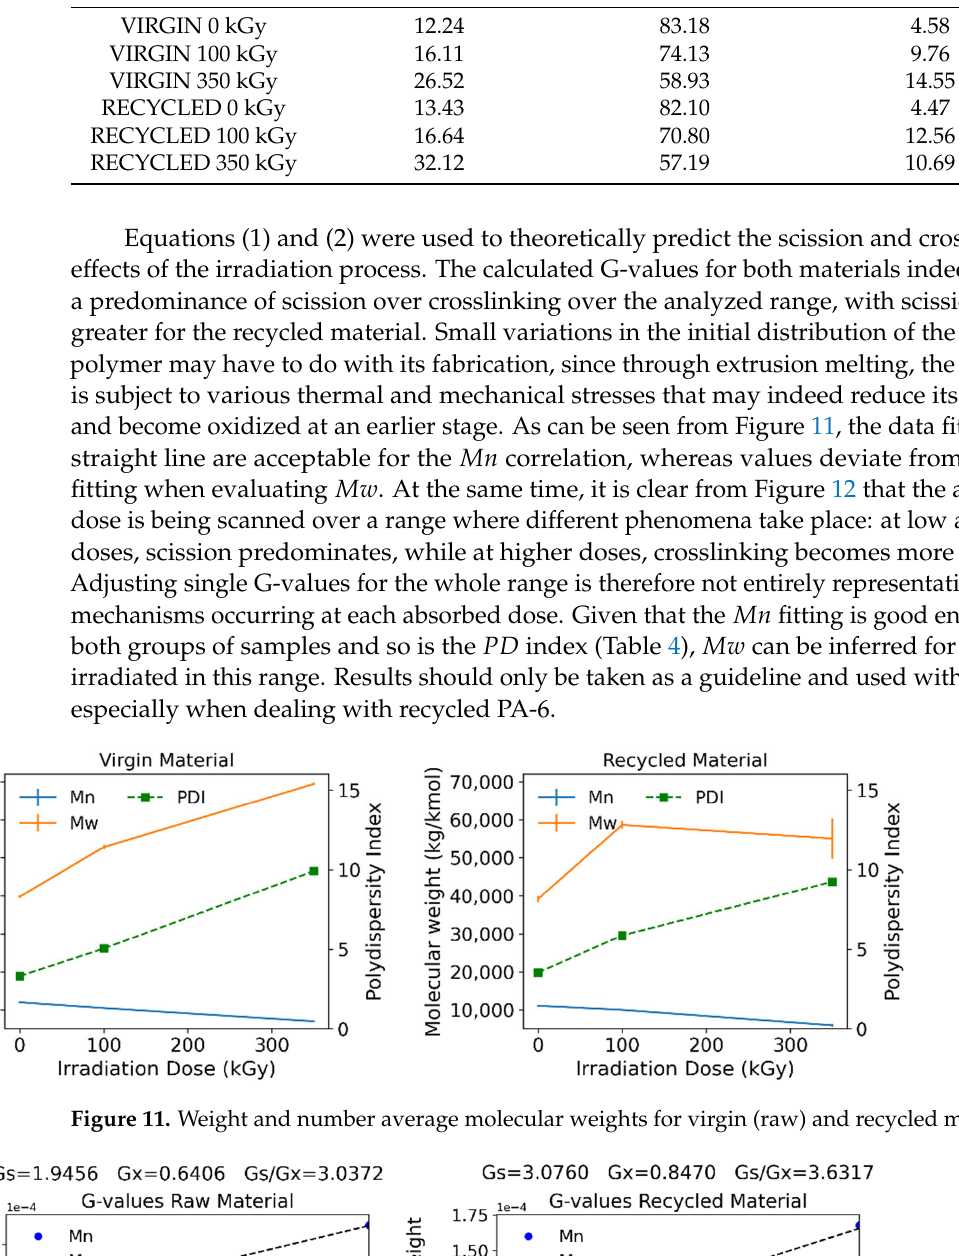
Table 3. Mass fractions for the sections split by the vertical dashed lines illustrated in Figure 10. Expressed as percentages.